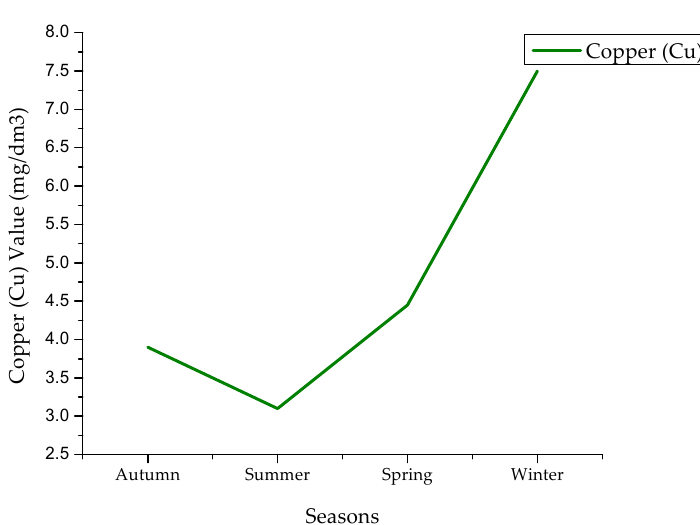
Figure 11. Concentration values for (Cu) from image during four seasons.